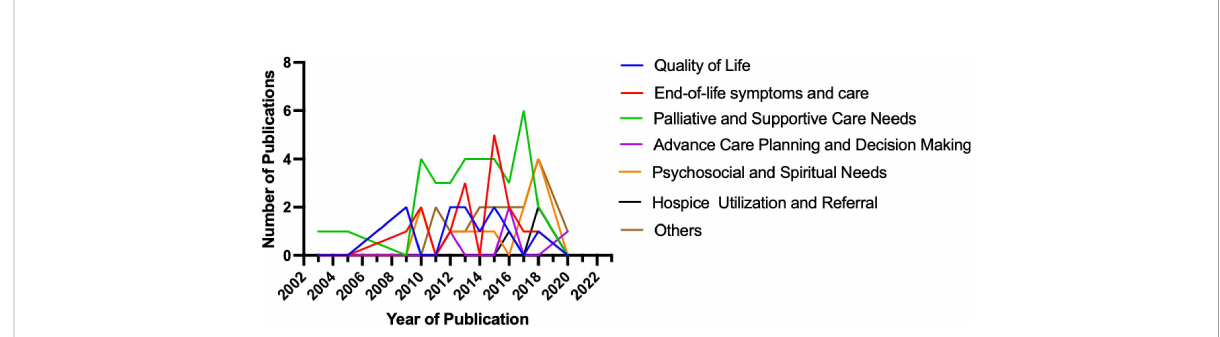
FIGURE 3 The top 100 cited article categories based on the primary